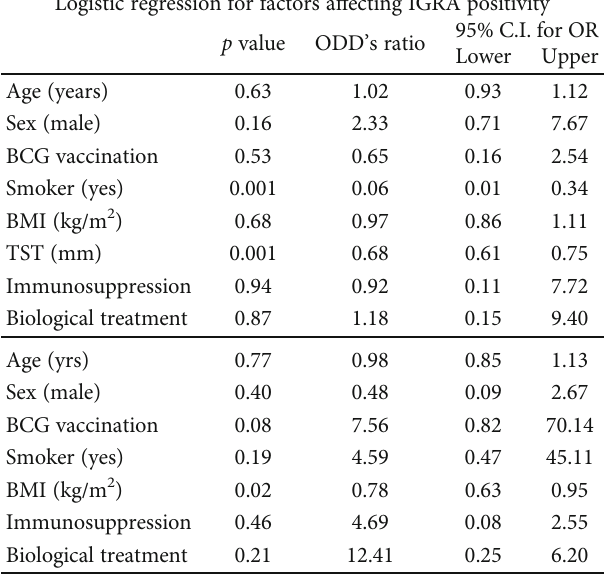
Table 5: Logistic regression for factors a ff ecting IGRA and TST positivity. Logistic regression for factors a ff ecting IGRA